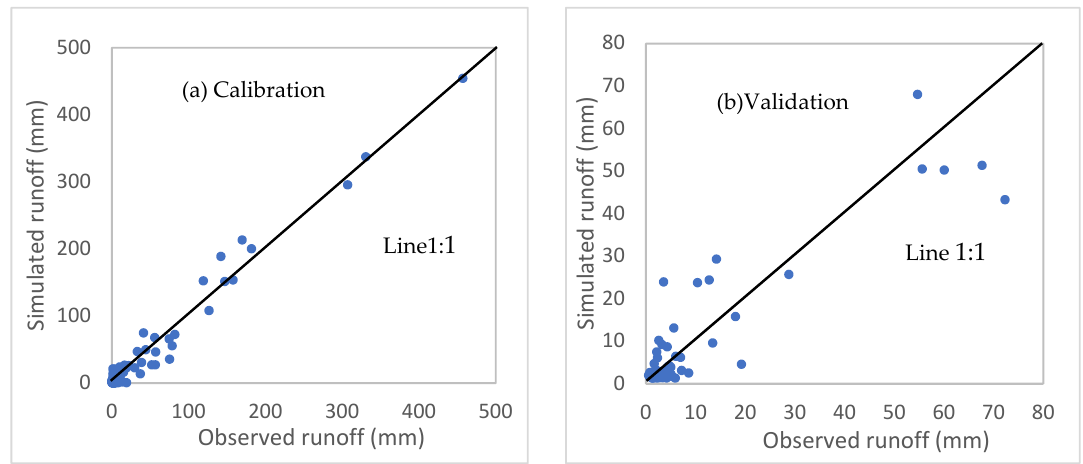
Figure 6. Scatter plot of the best input pattern (bold type in Table 5) of ANN models during the calibration ( a ) and validation ( b ) phases in the Haughton River catchment.